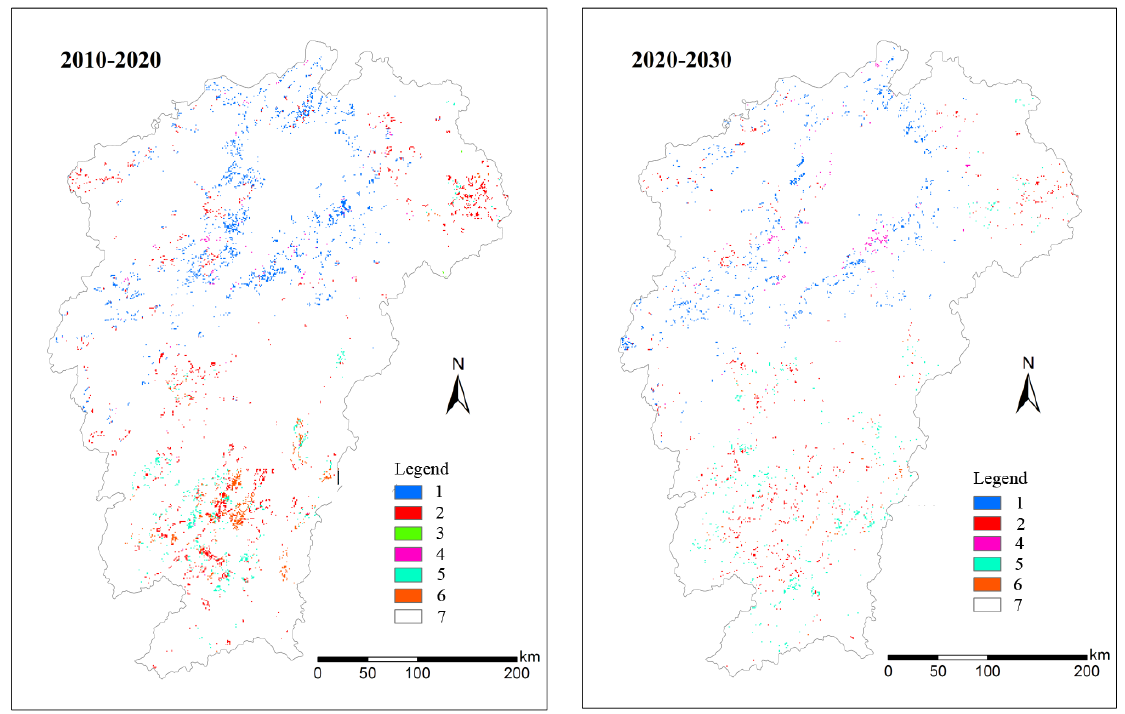
Figure 10. Conversion of forestland under the MESSAGE climate scenario: ( 1 ) closed forest converted to non-forestland; ( 2 ) closed forest converted to other forest; ( 3 ) other forest converted to closed forest; ( 4 ) other forest converted to non-forestland; ( 5 ) shrub land converted to garden area; and ( 6 ) non-forestland converted to